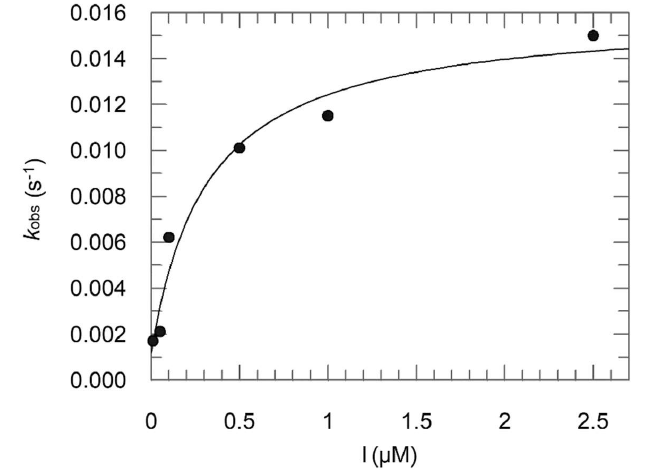
Figure 4. Example of a replot of the k obs values for the progress curves from Figure 2 as a function of inhibitor concentration. The intercept with the y -axis provides an estimate of k 4 , while the maximum value of k obs at infinite inhibitor concentration reflects the sum of k 3 and k 4 . The concentration of inhibitor yielding a half-maximal value of k obs is equal to K i app .